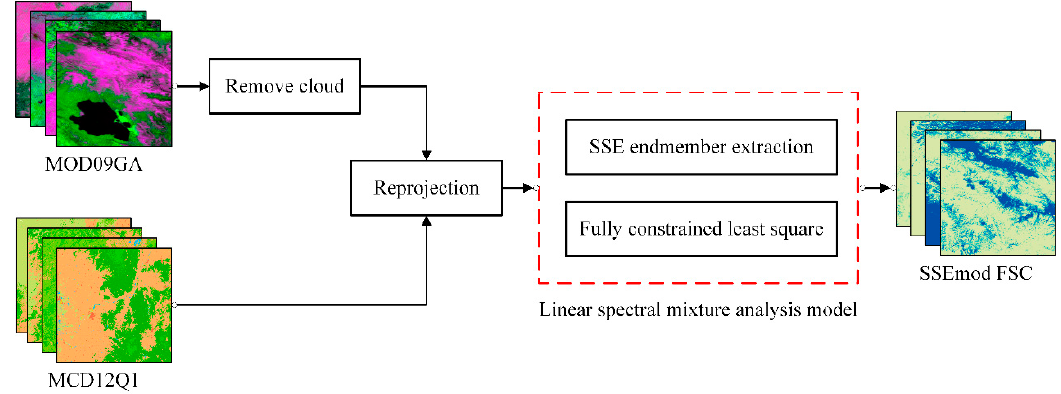
Figure 7. SSEmod FSC retrieval workflow. Firstly, eliminate cloud-contaminated pixels because it’s surface reflectance are very similar to snow-covered pixels. Afterward, MOD09GA and MCD12Q1 were re-projected as the same projection system with Landsat 8. Ultimately, the linear spectral mixture analysis model is utilized for SSEmod FSC retrieval.